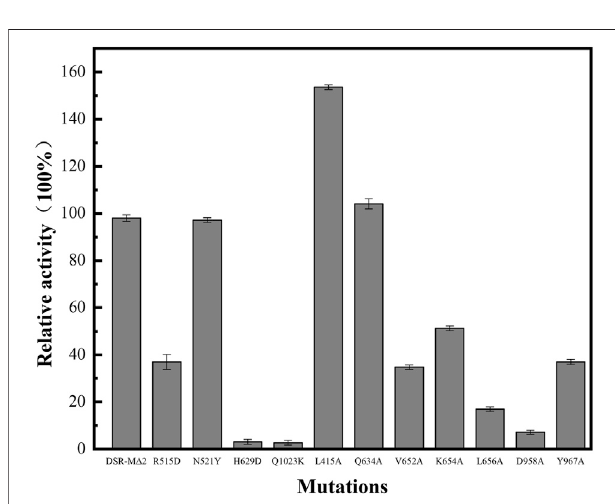
FIGURE 2 | Enzyme activity of DSR-M Δ 2 and its eleven mutants.